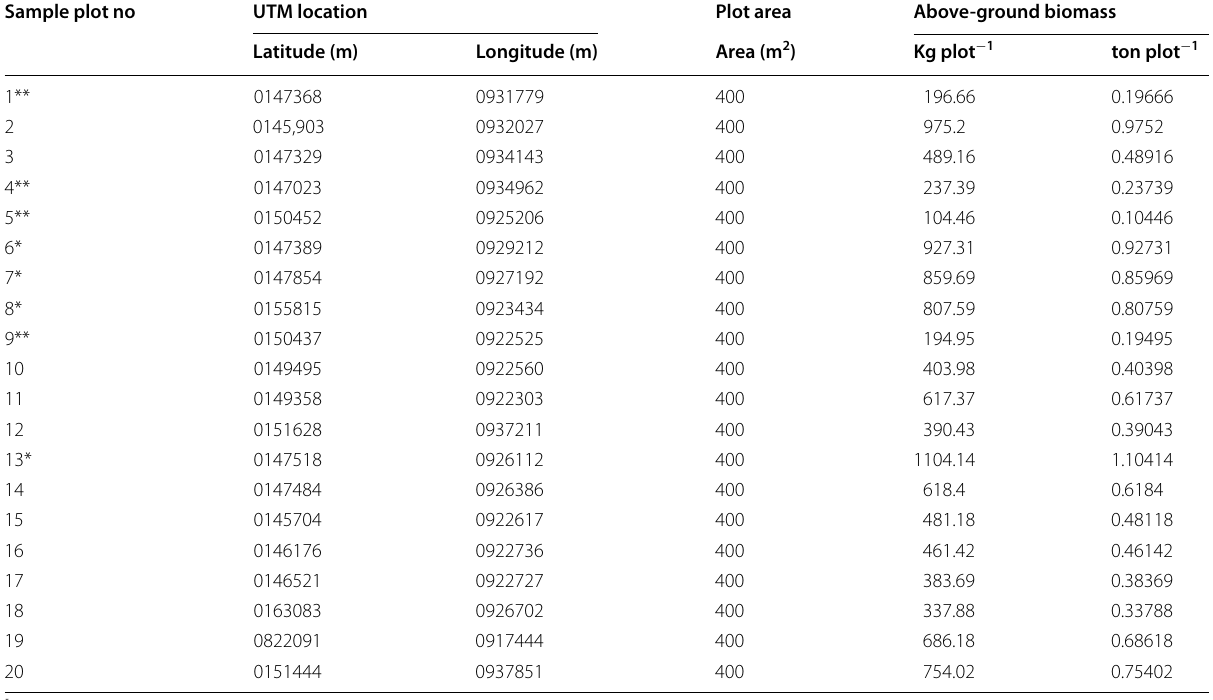
Table 5 Forest above-ground biomass estimated from field sample plot measurements Sample plot no